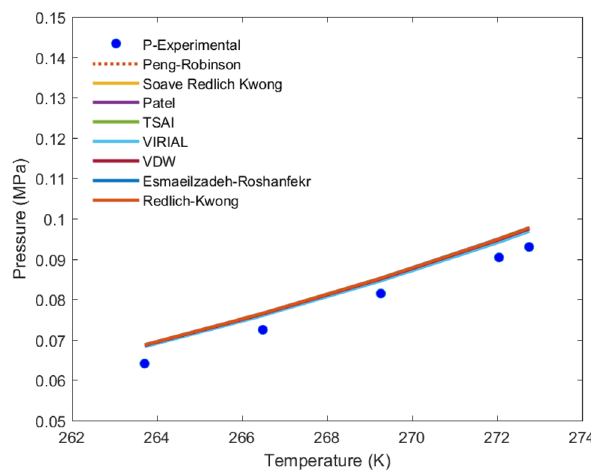
Fig. 9 Predicted pressure versus experimental plot for I – H – V phase region, AAD %, [Min/Max] of [3.1/4.0]